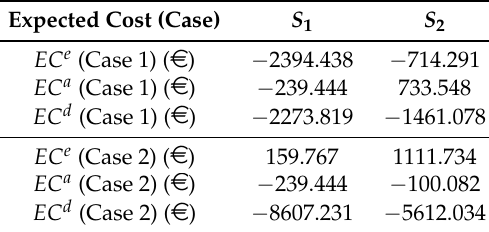
Table 2. Impact of the proposed iterative algorithm on the expected costs of end-users, aggregators, and the DisCo.